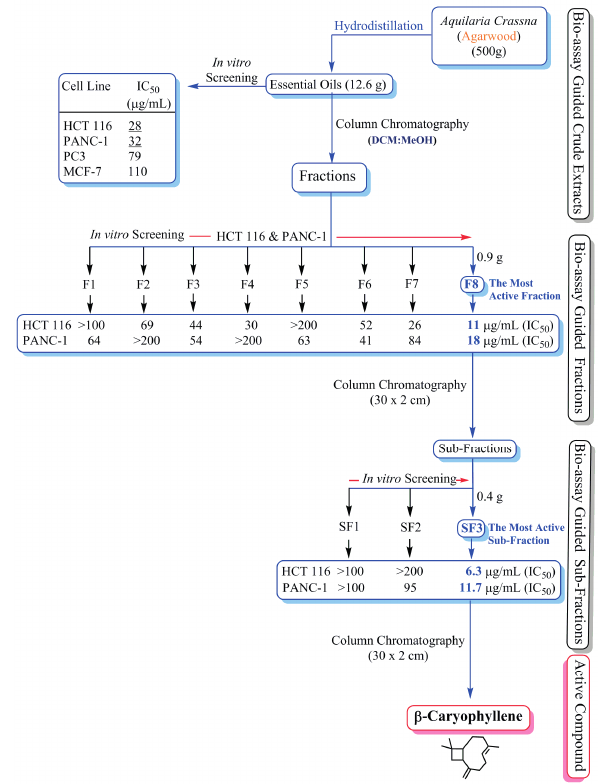
Figure 1. Schematic diagram showing the bioassay (anti-proliferative assay)-guided isolation of β -caryophyllene from the essential oils of Aquilaria crassna